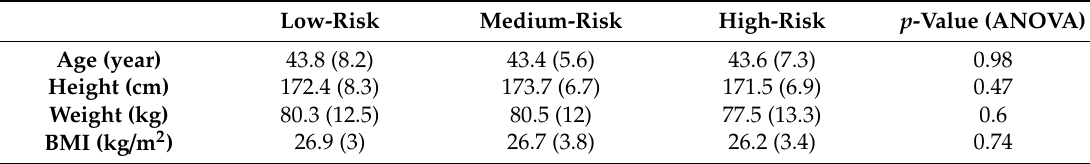
Table 1. Statistical analysis on demographic data from three risk groups. The numbers in parenthesis indicated the standard